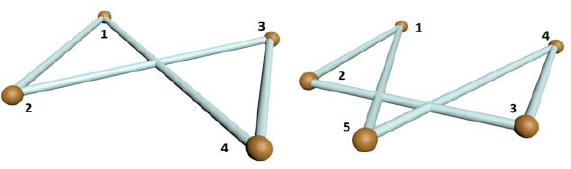
Figure 5. Healing CP_SELFINT error